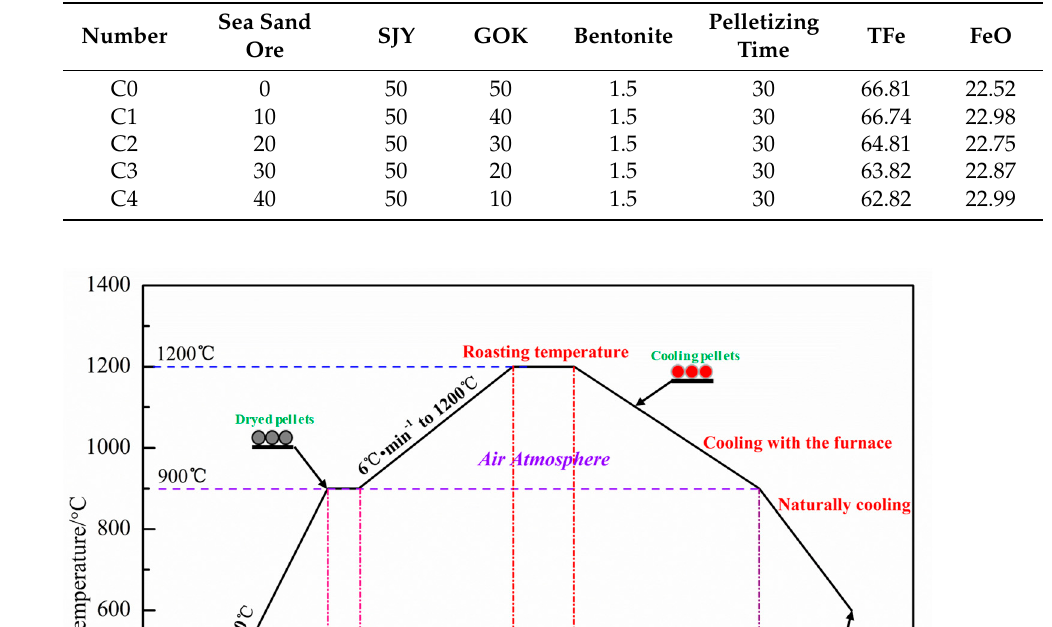
Table 4. Ingredient scheme and composition of green pellets (mass/%).